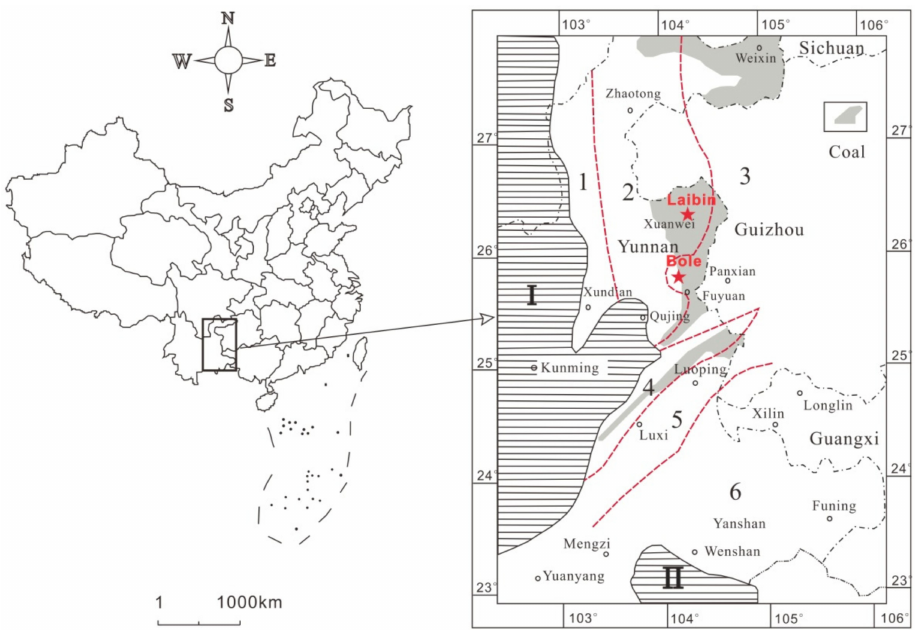
Figure 1. Location of the Bole and Laibin Coal Mines and distribution of depositional environments during the Late Permian in the Eastern Yunnan Province, China. I: Kangdian Upland. II: Northern Vietnam Upland. 1: Piedmont alluvial plain. 2: Littoral alluvial plain (basal clinoform). 3: Littoral plain. 4: Epicontinental littoral clinoform. 5: Luxi–Luoping submarine trench. 6: Restricted carbonate platform. Modified from Dai et al.